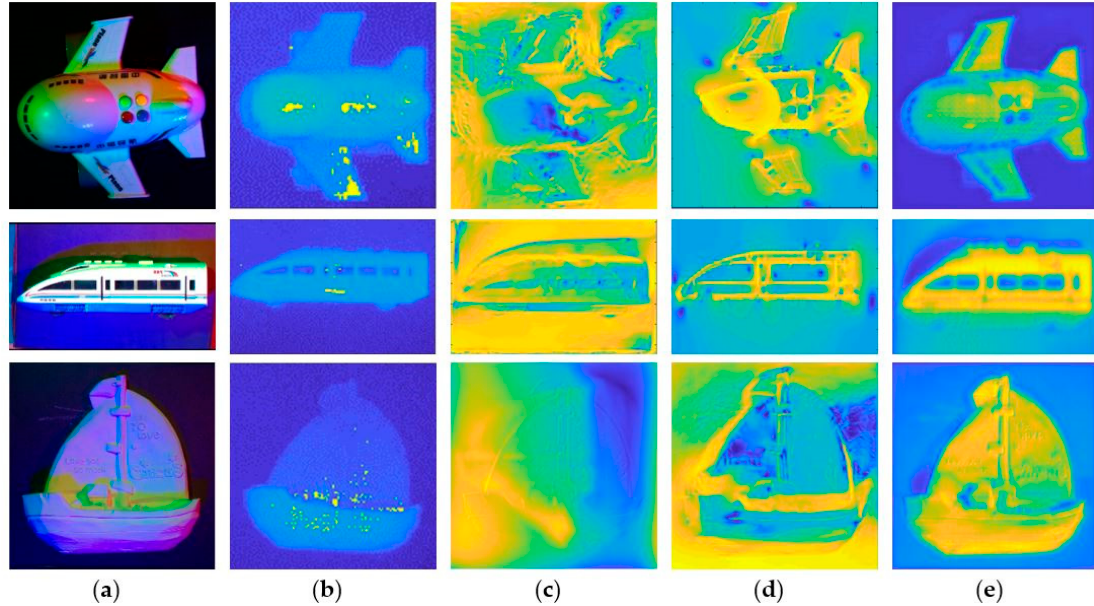
Figure 7. The final results produced by Matlab’s imagesc function. ( a ) The input images. ( b ) The outputs of Kinect. ( c ) The result of the depth estimation of traditional multi-spectral PS. ( d ) The result of [10]. ( e ) The result of the depth estimation of our method.